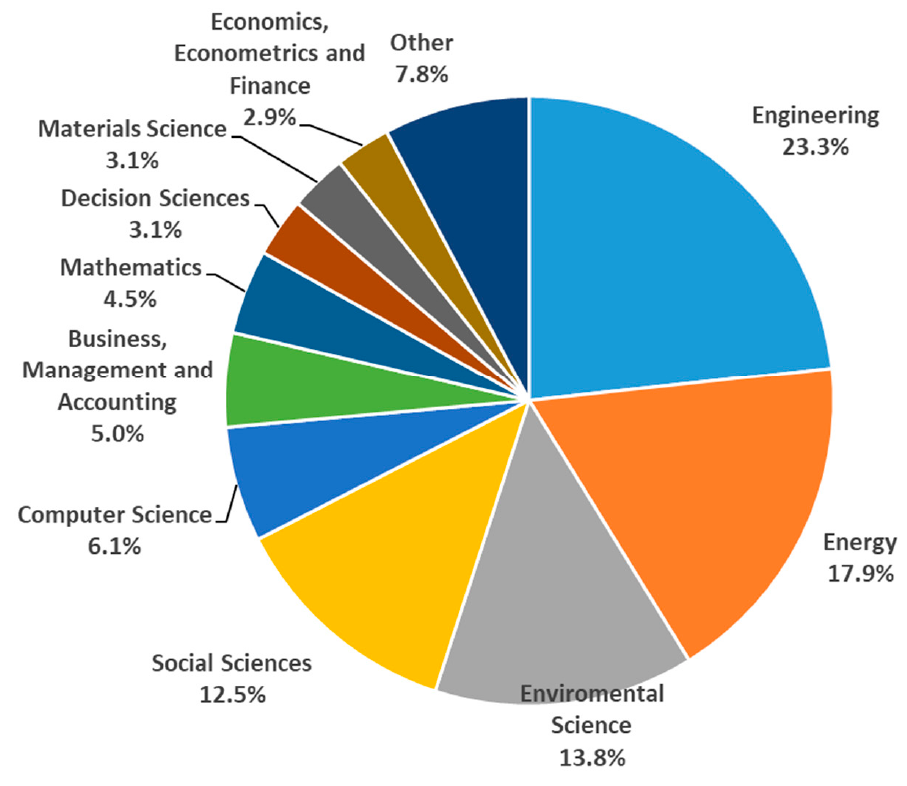
Figure 4. Documents by subject area.